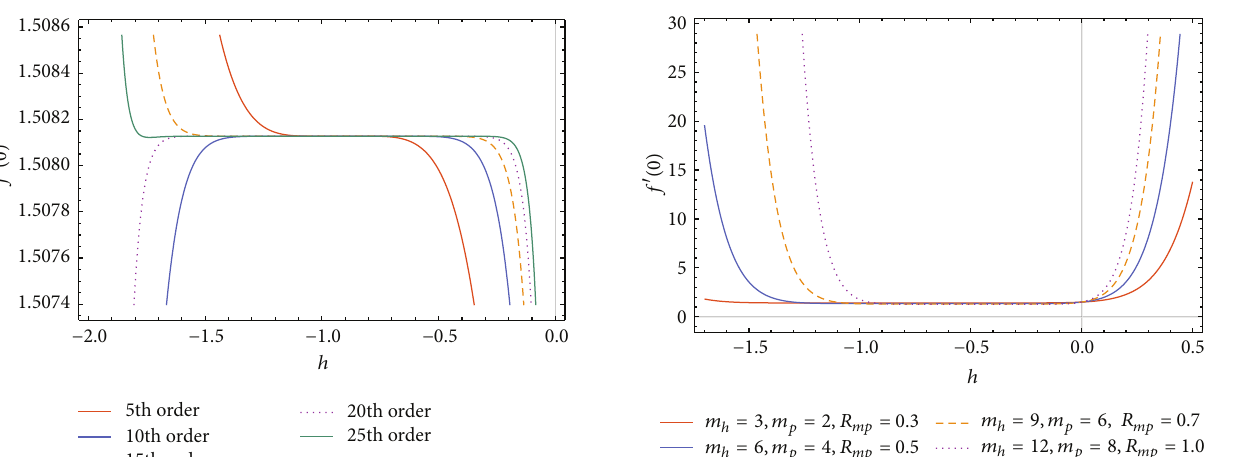
values of 𝑅 𝑚𝑝 and for fixed values of 𝑚 ℎ , 𝑚 𝑝 are displayed